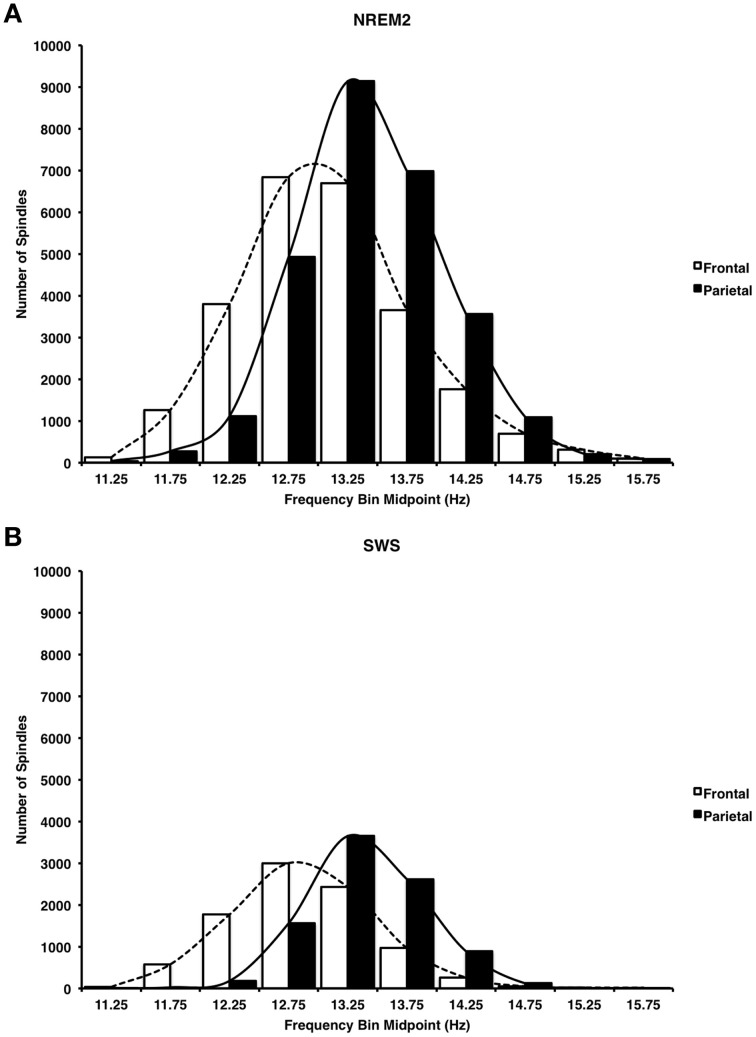
Histogram of mean spindle frequencies at frontal and parietal sites during NREM2 (A) and SWS (B). Fast spindles predominated parietal regions, whereas slow spindles predominated frontal regions.